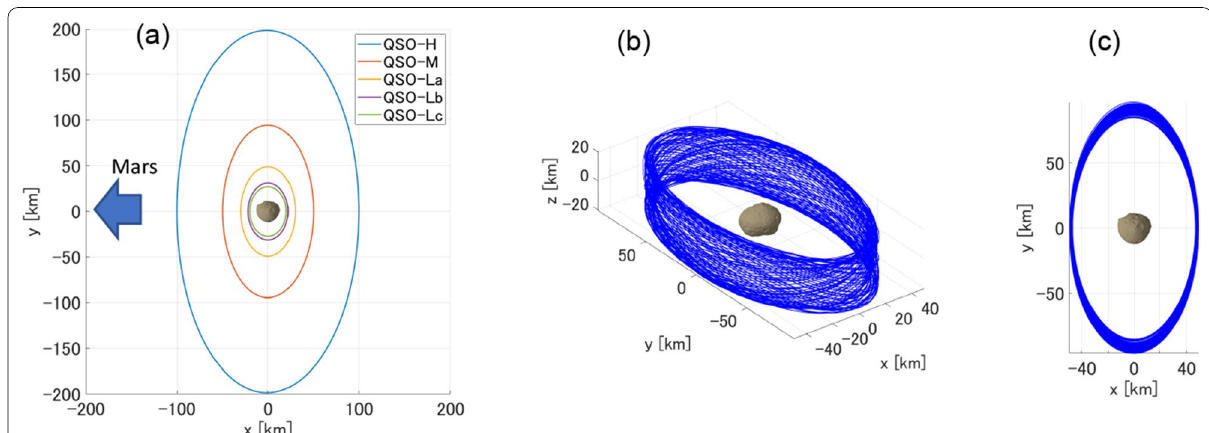
Fig. 2 Observational orbits around Phobos. a Five QSOs are drawn in the Phobos fixed frame with Phobos at the center, in which the xy plane is the Phobos orbital plane and the negative x axis direction is the direction to Mars. Phobos—Mars direction is fixed so that Phobos does not rotate in the figure, because of the tidal locking. Characteristics of each QSO are shown in Table 1. b 3D‑QSO with xy dimension of 50 km height from the equatorial plane of Phobos of z 20 km. c The same 3D‑QSO viewed from z = ±